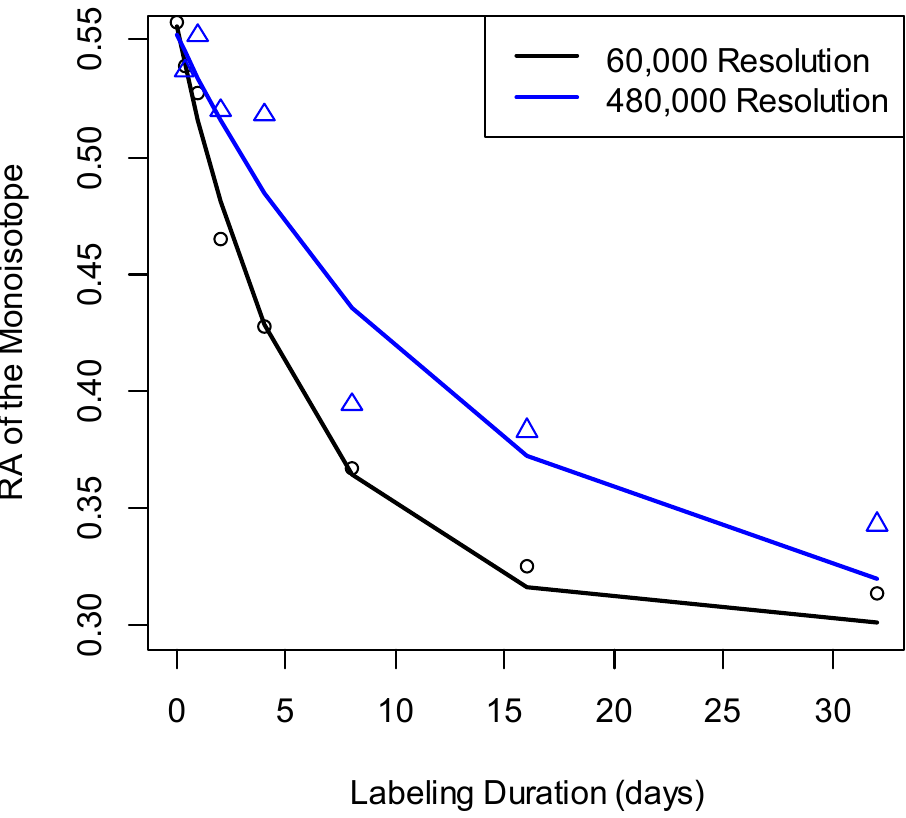
Figure 4. The changes in RA estimation that accompanied the increase in mass resolution affected the rate constant estimation. Measurements (empty circles, and triangles) of the RA of the monoisotopic peak for the Albumin peptide “TNCDLYEK” and their fits (lines). The fit to the experimental data at 60,000 resolution (black line) produced the rate constant of 0.1724 day − 1 . The rate constant from the data at 480,000 resolution (blue line) was 0.077 day − 1 .